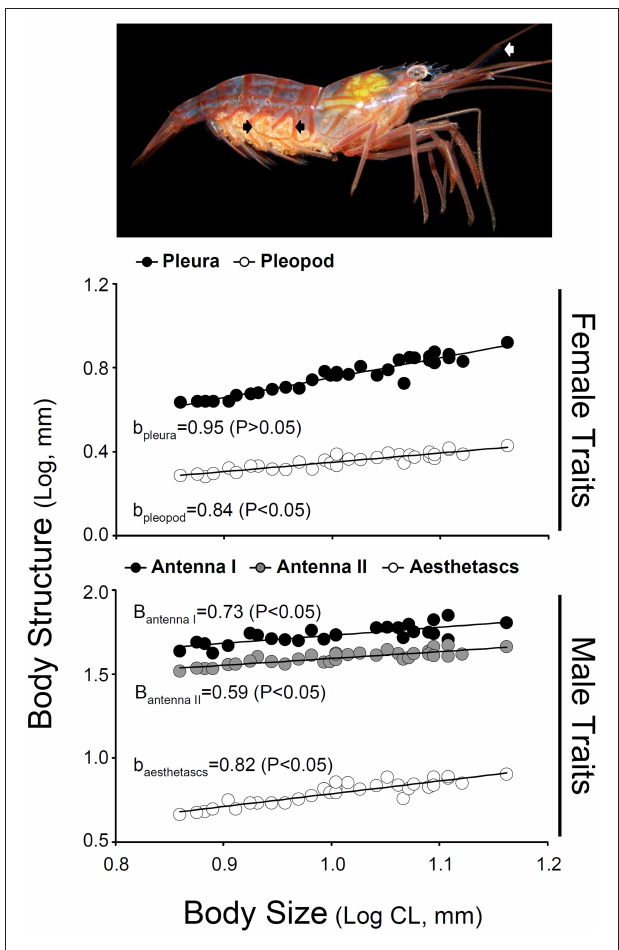
FIGURE 3 | Relative growth of male traits (first antenna, second antenna, and accessory branch length) and female traits (pleura of second abdominal segment and second pleopod width) as a function of carapace length in hermaphrodites of Lysmata wurdemanni . Measurements are in mm. The photograph on top indicates the position of the accessory branch (aesthetasc row, white arrow) and the pleura of second abdominal segment (black arrows) in a simultaneous hermaphrodite (lateral view). Linear regression equations obtained after log-log transformation of the data are shown for each sex on